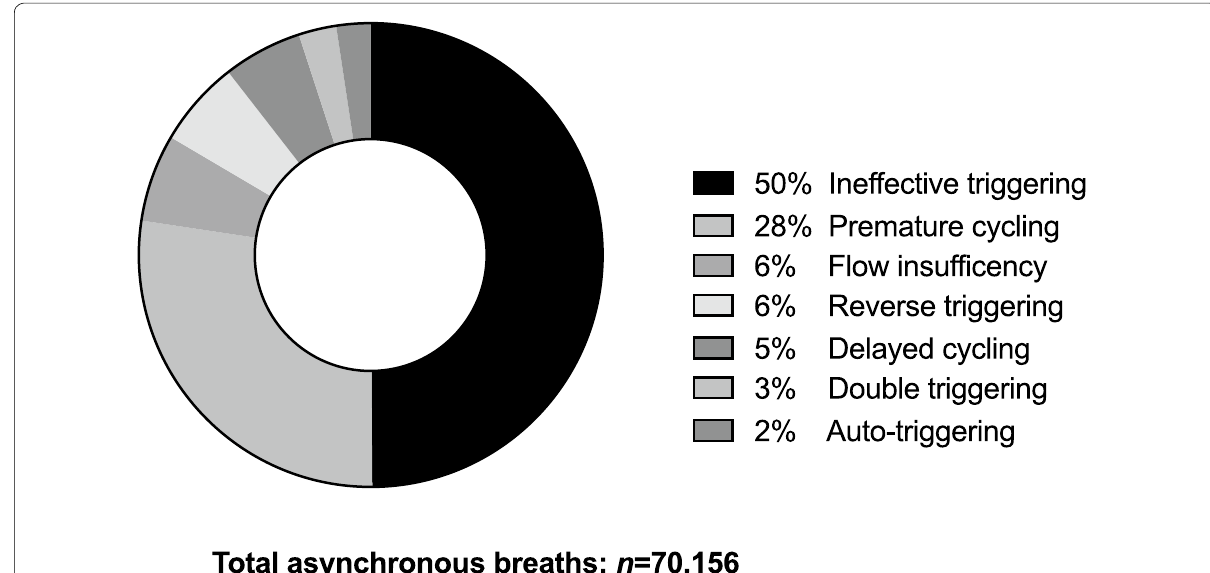
Fig. 2 The proportion of different types of patient–ventilator asynchrony in breath‑based analysis. A total of 70,156 asynchronous breaths were detected